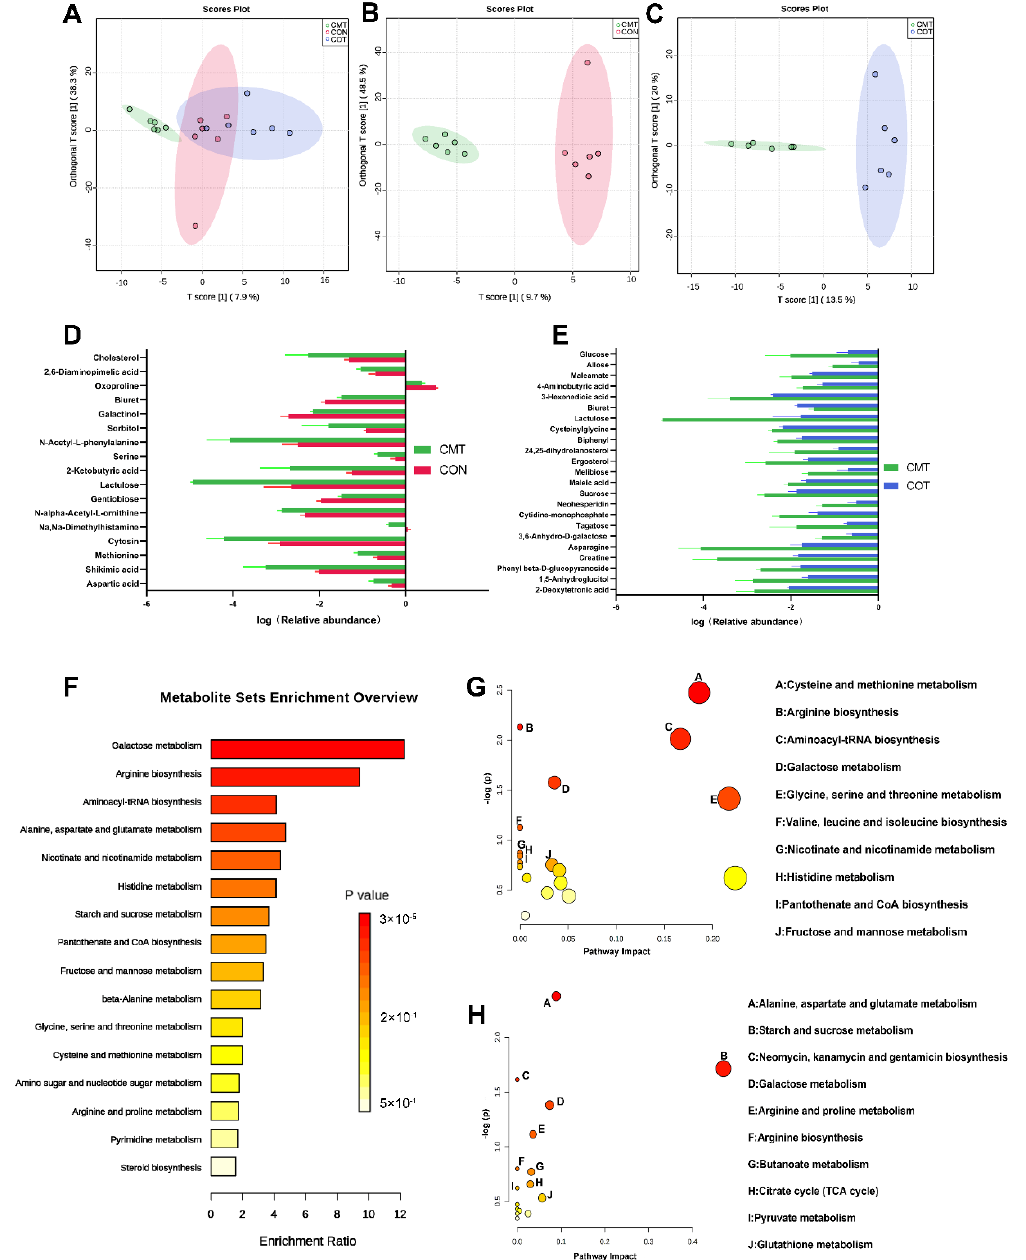
Figure 6. Non-targeted metabonomics derived from the GC/MS metabolite profiles of ileum contents. ( A ) OPLS-DA score map of separate comparisons among the three groups. ( B ) OPLS-DA score map of separate comparisons between the CMT group and the CON group. ( C ) OPLS-DA score map of separate comparisons between the CMT group and the COT group. ( D ) Significantly differential metabolites between the CON group and the CMT group. ( E ) Significantly differential metabolites between the COT group and the CMT group. ( F ) Differential metabolites were classified by KEGG pathway enrichment and significance analysis. ( G ) Pathway enrichment analysis performed using the significantly different intestinal metabolites between the CON group and the CMT group. ( H ) Pathway enrichment analysis performed using the significantly different intestinal metabolites between the COT group and the CMT group.